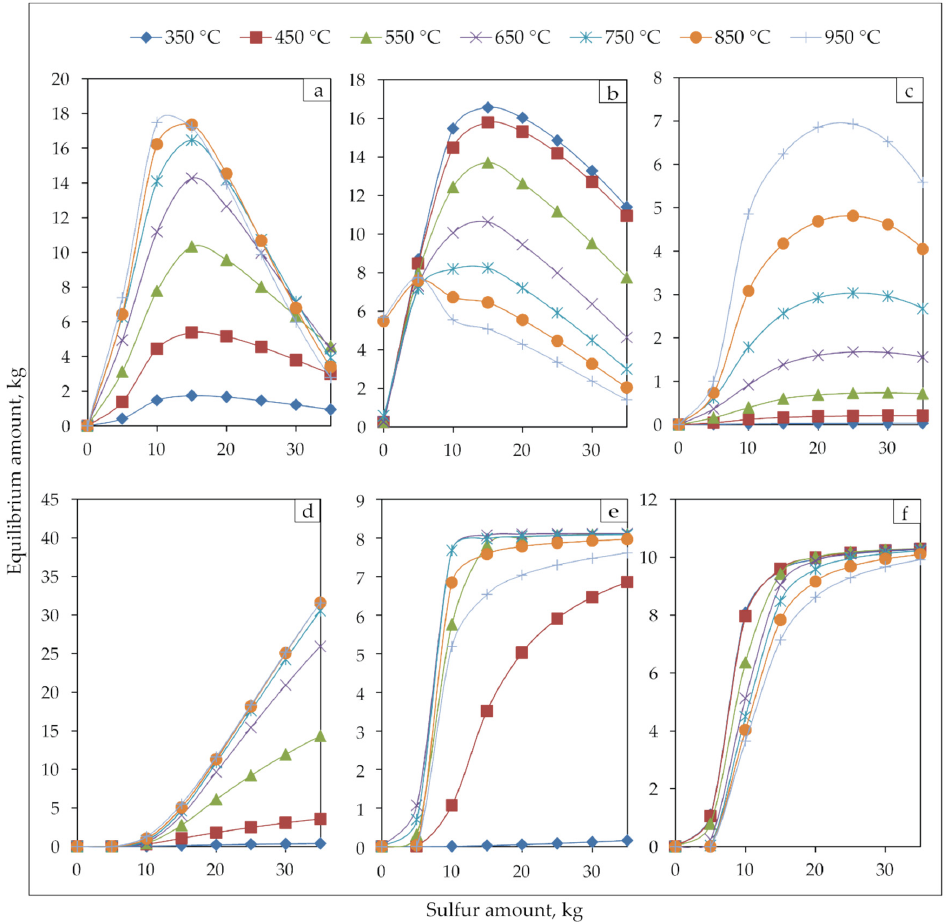
Figure 9. Equilibrium phase diagrams of ( a ) Fe 3 O 4 , ( b ) Fe 2 O 3 , ( c ) FeO, ( d ) FeS, ( e ) PbS, and ( f ) ZnS during jarosite-PbAg sludge with different sulfur amount at 350, 450, 550, 650, 750, 850 and 950